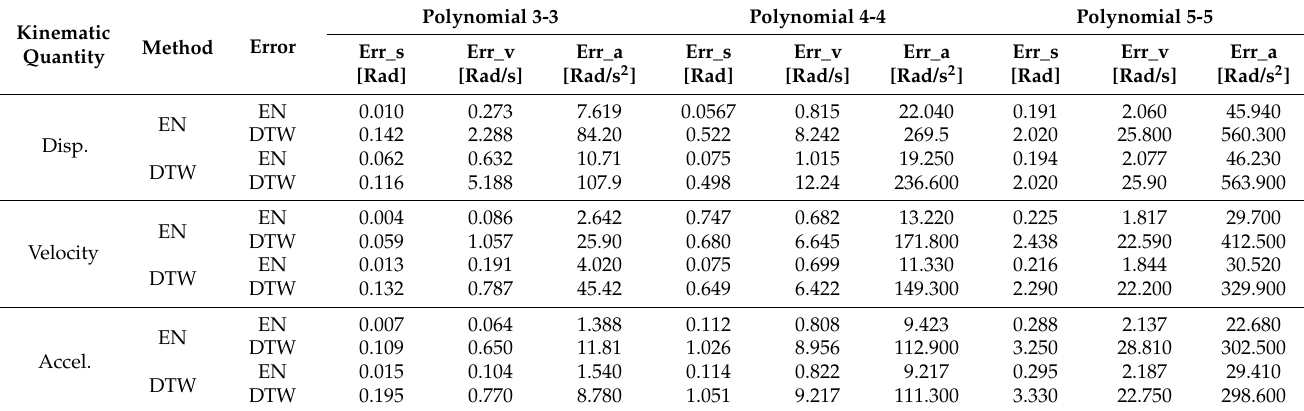
Figure 12. Comparison between the experimental law of motion (light blue) and modified trapezoidal laws for each phase (with equal coefficients values) after identification based on displacement by adopting the DTW algorithm.